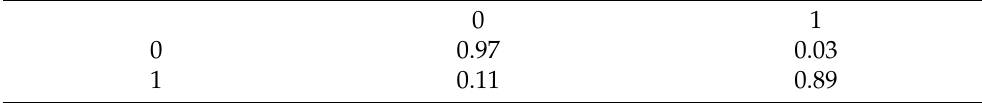
Table A2. Confusion matrix for the